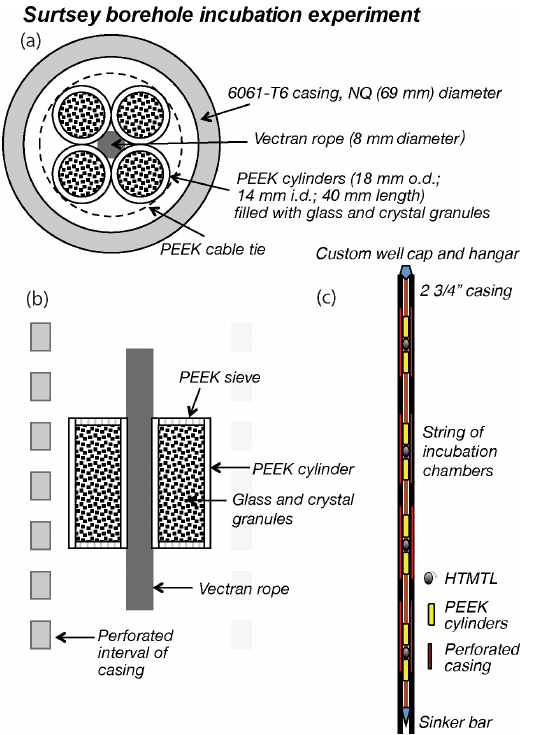
Figure 3. Design of the PEEK incubation chambers (PEEKins) and subsurface observatory in ICDP borehole 5059-1-C (SE-02b). (a) Schematic top view of the PEEKin as it is deployed in the bore- hole; (b) schematic side view of the PEEKin at intervals where the casing is perforated. (c) Sketch of the downhole observatory, which comprises an NQ anodized aluminium casing with five perforated sections, an inner Vectran ™ rope hung from the wellhead with a sinker bar attached at its lower end and five incubation experiments placed at the perforated sections (Table 1).